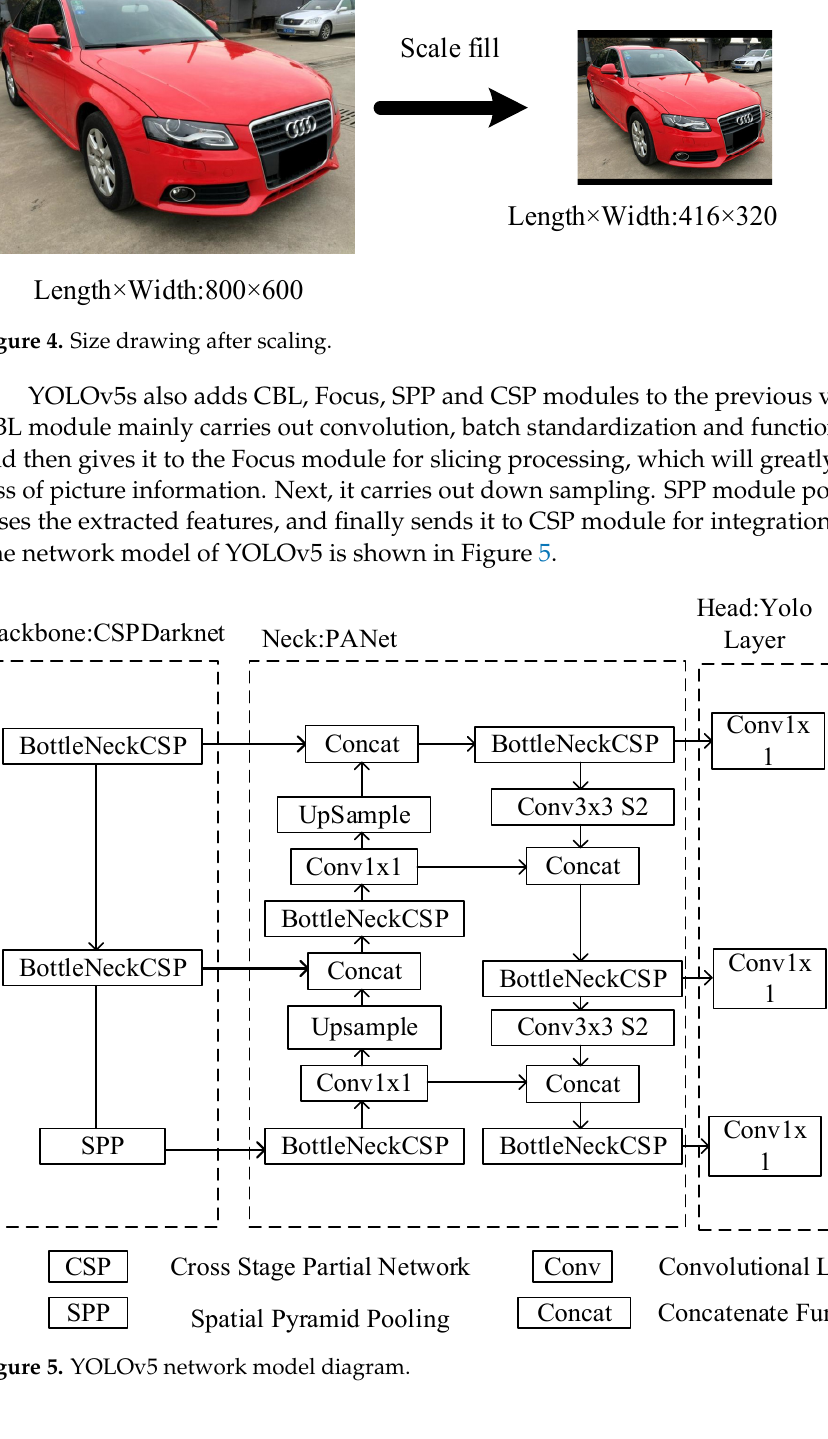
Figure 3. Initial predicted coordinates for the anchor box.